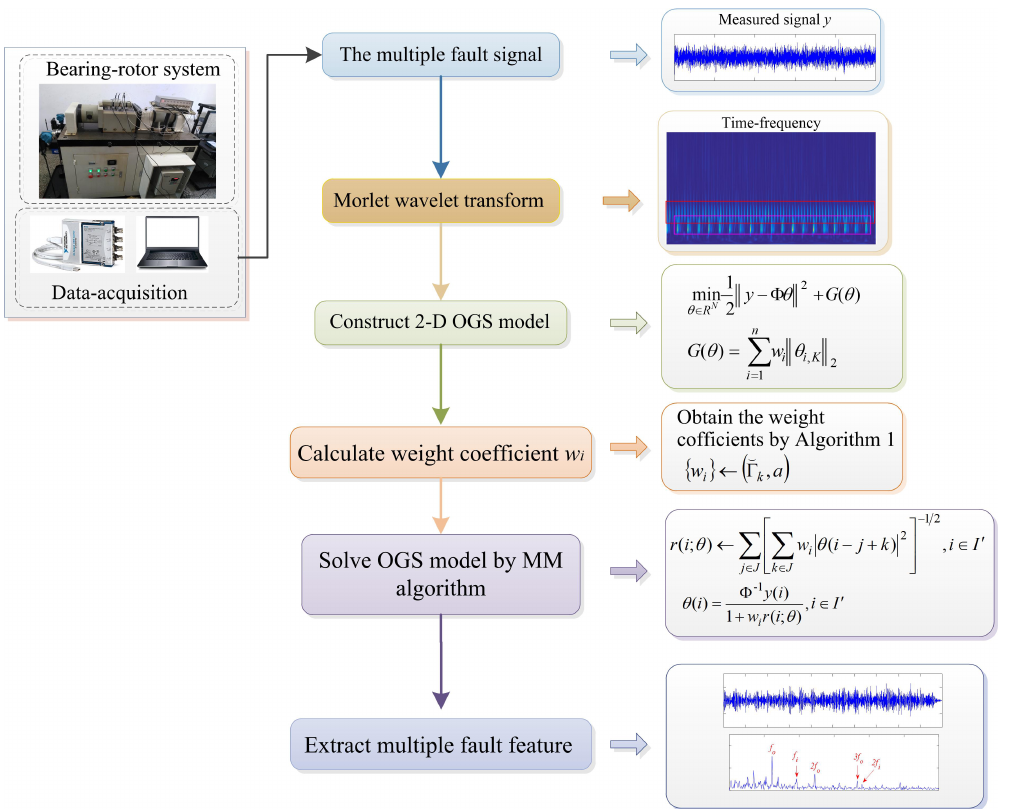
Figure 3. The fault feature extraction algorithm based on